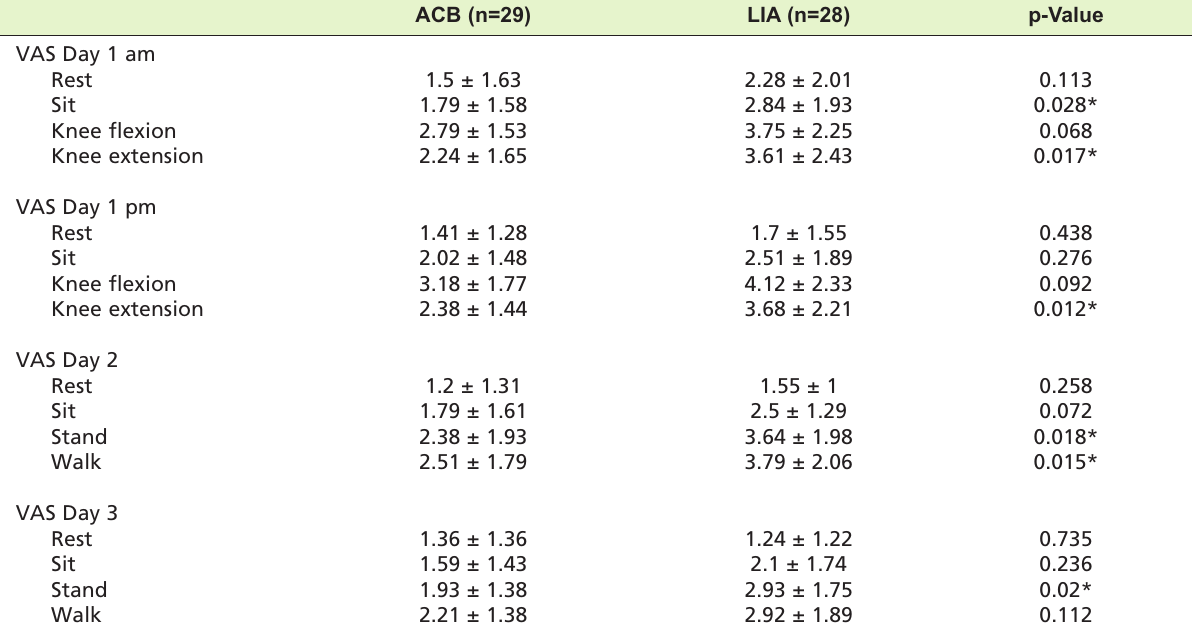
Visual analog scale on post-operative day Table III: